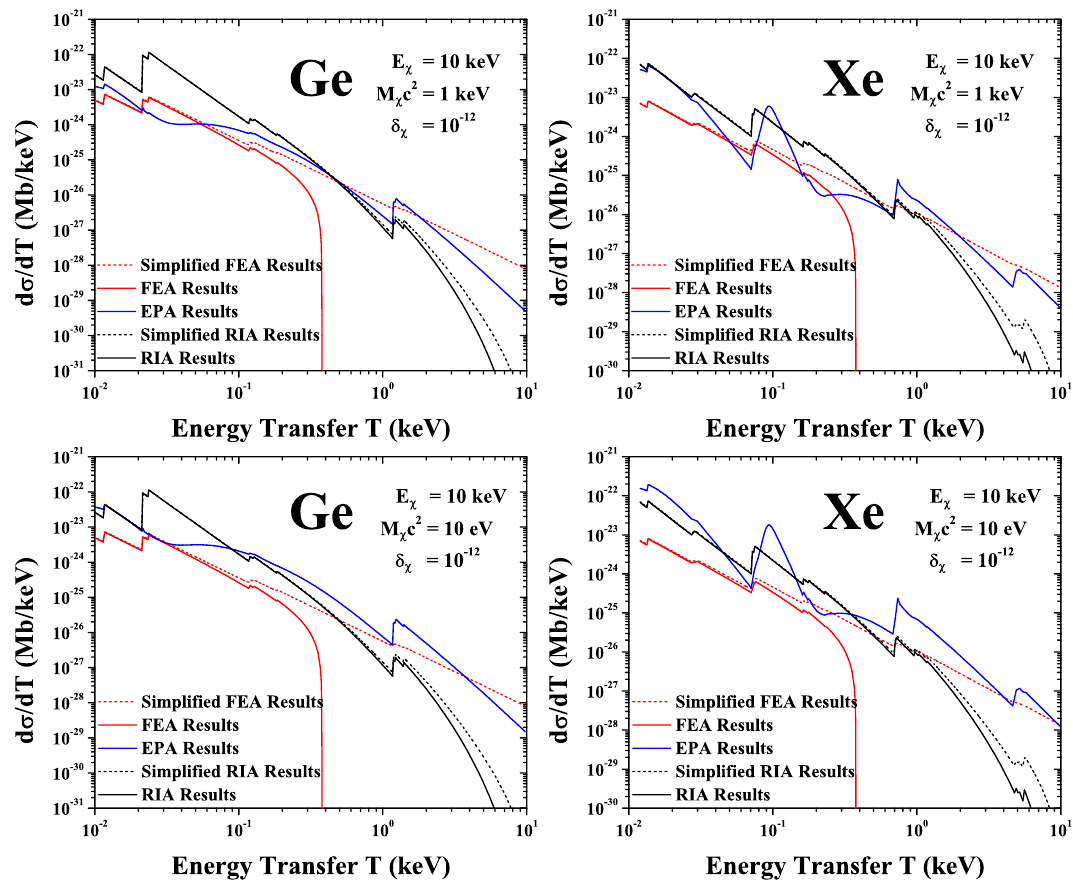
Figure 5 . Differential cross sections for atomic ionization process of Ge and Xe atoms induced by millicharged dark matter particles. In this figure, the mass and initial energy of millicharged particle is chosen as m = 10 keV, and the dark matter particle millicharge is chosen to be 2 = 1 keV, E χ c χ δ χ = 10 − 12 . The upper and lower panels show the cases of different millicharged particle mass: the upper panel correspond to m 2 = 1 keV, and the lower panel correspond to m 2 = 10 eV. In this χ c χ c figure, we compare the numerical results on differential cross section dσ/dT calculated in the FEA, EPA and RIA approaches. The red solid lines correspond to the FEA results calculated through eq. (A.3); red dashed lines represent the simplified FEA results calculated through eq. (A.4); blue lines stand for the EPA results calculated from eq. (B.7); black solid lines show the RIA results calculated using eq. (4.22); and black dashed lines present the simplified RIA results calculated using eq.